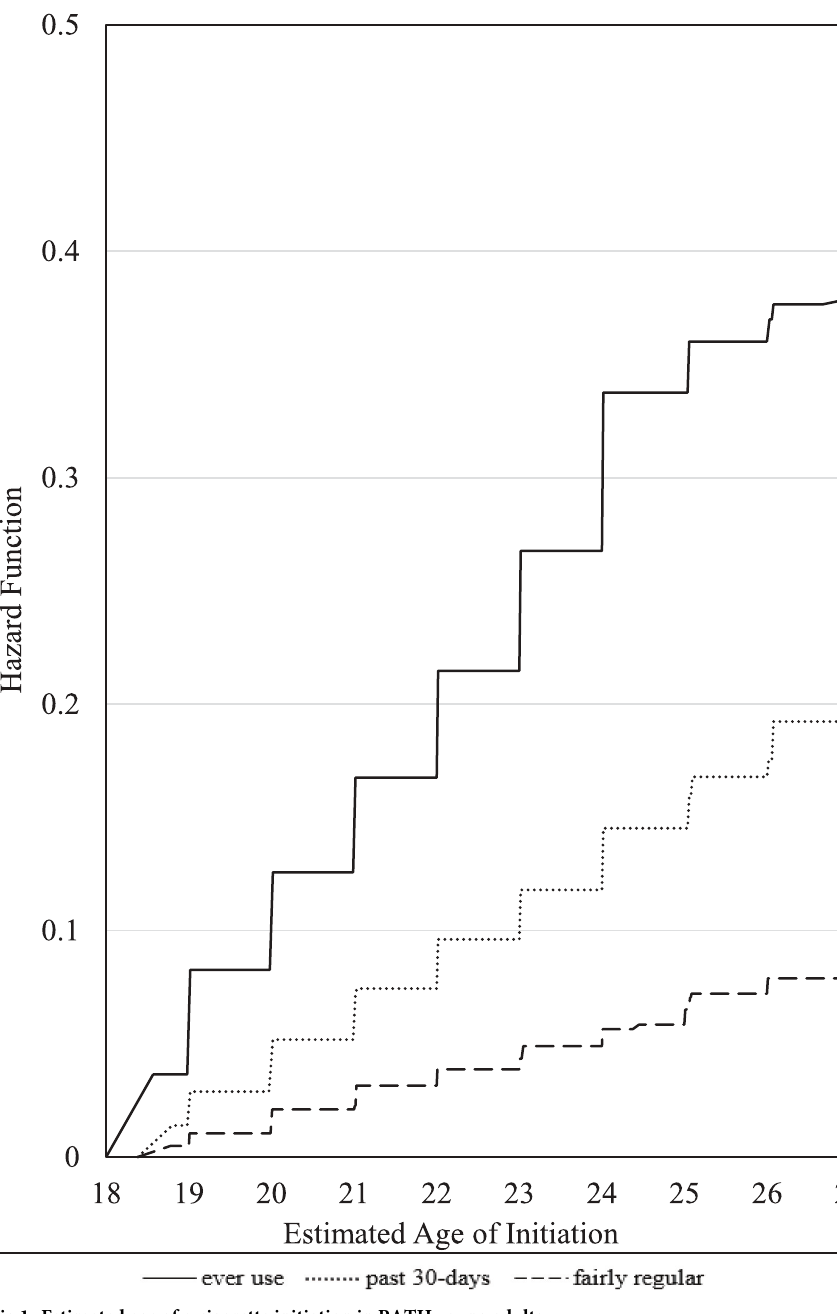
When adjusting for sex and race/ethnicity, previous ever use of cigarettes, cigarillos, filtered cigars, and hookah were associated with an increased risk of an earlier age of ever e-cigarette initiation. When adjusting for sex and race/ethnicity, previous ever use of cigarettes, cigarillos, filtered cigars, and hookah were associated with an increased risk for an earlier age of past